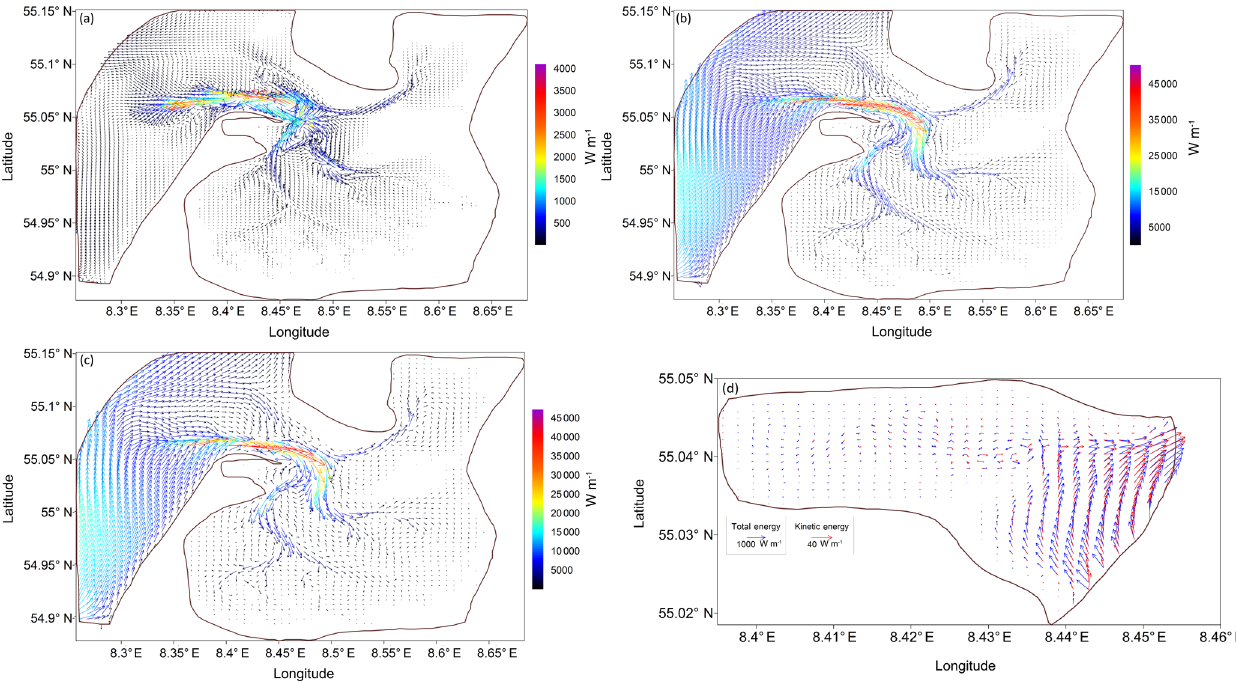
Figure 5. The flux of tidal energy (summary tide): (a) kinetic; (b) potential; (c) total ( E λ E θ ); and (d) the total (blue arrows) and kinetic (red arrows) energy fluxes for the Königshafen subarea. The potential energy flux behaviour is visually identical to the total energy fluxes